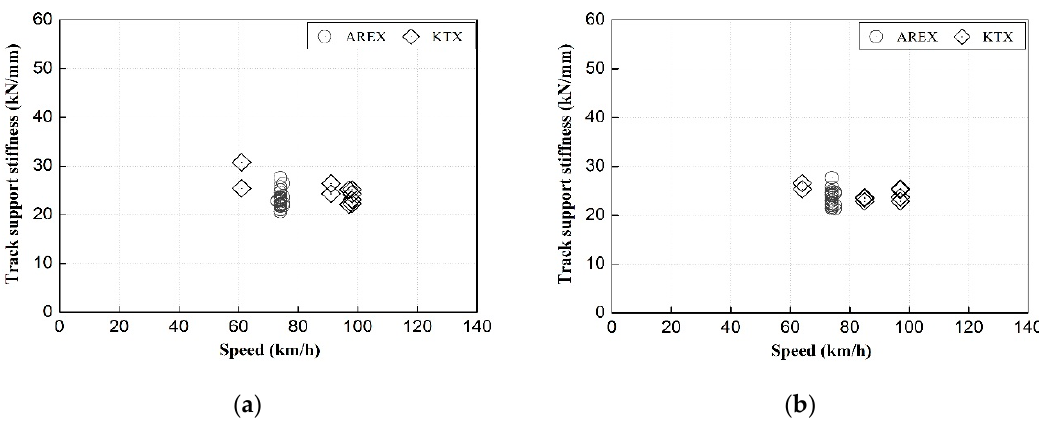
Figure 15. Calculated track support stiffness according to train type (including the track girder bending stiffness). ( a ) Before rail pad replacement and ( b ) after rail pad replacement.